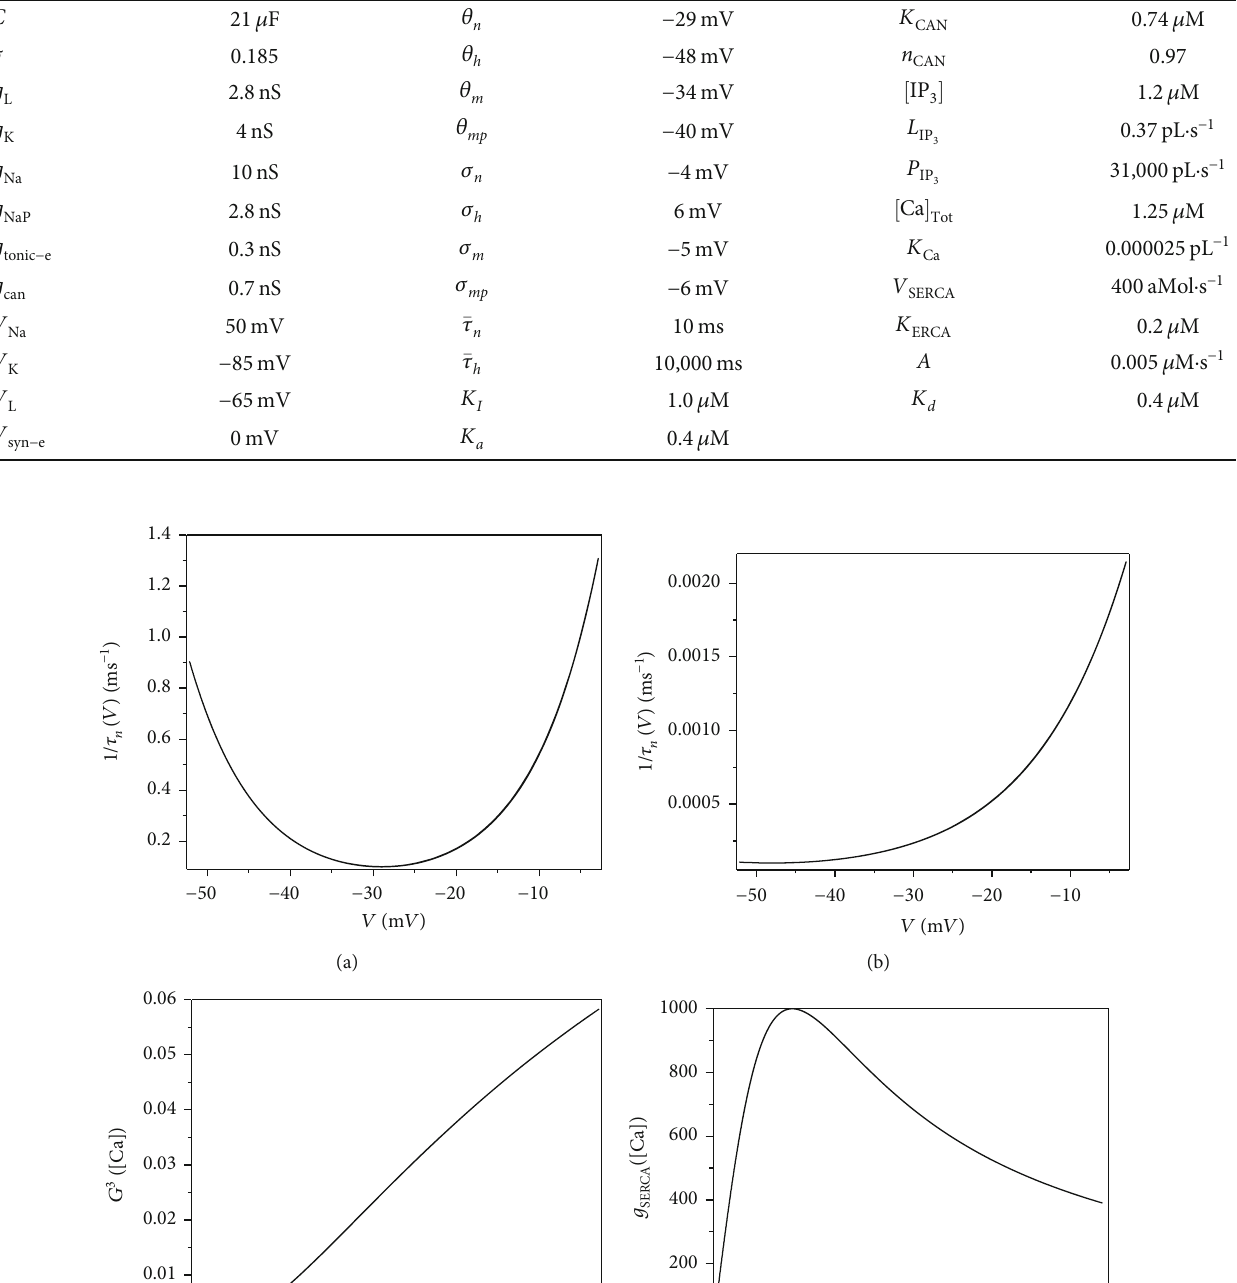
ð V Þ with membrane potential V , (c) G 3 ð½ Ca (cid:2)Þ with ½ Ca (cid:2) , h